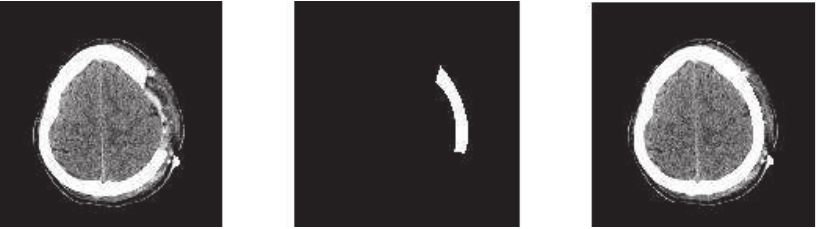
Figure 6. Construction of fractured part using GC 1 rational Ball